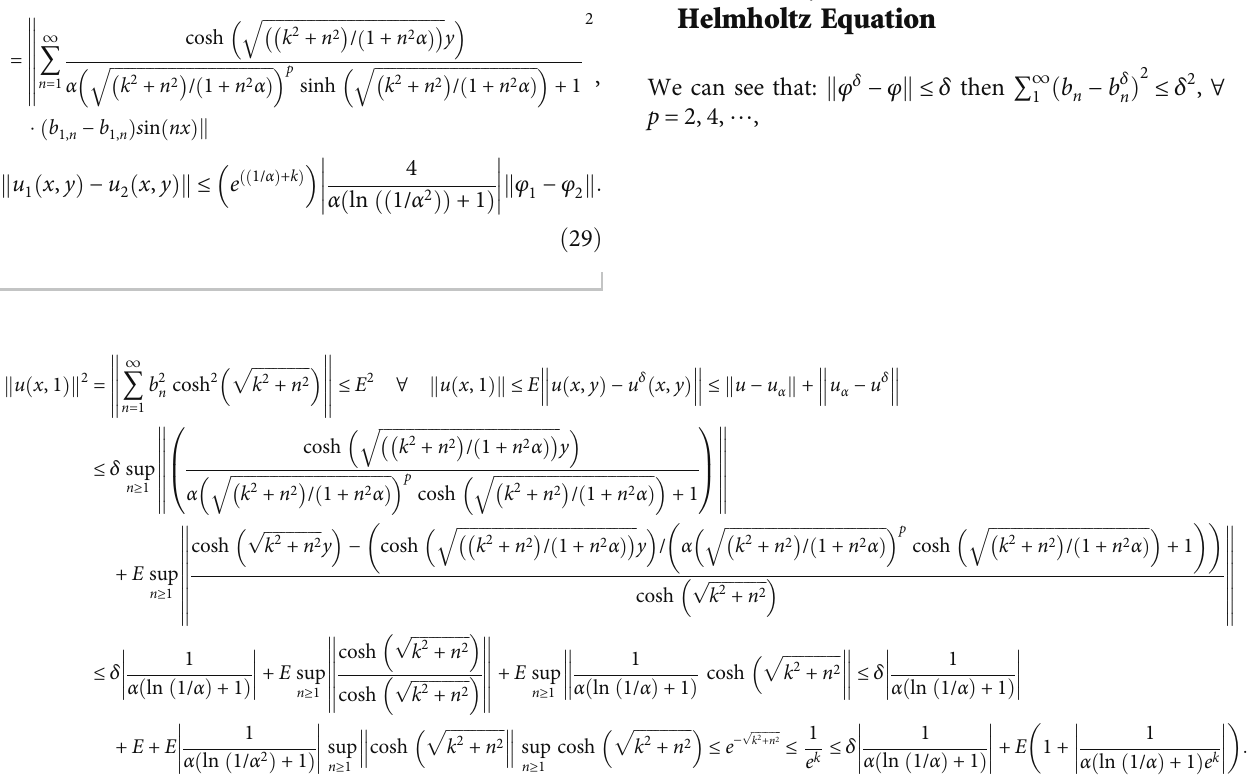
p ffiffiffiffiffiffiffiffiffiffiffiffiffiffi k 2 + n 2